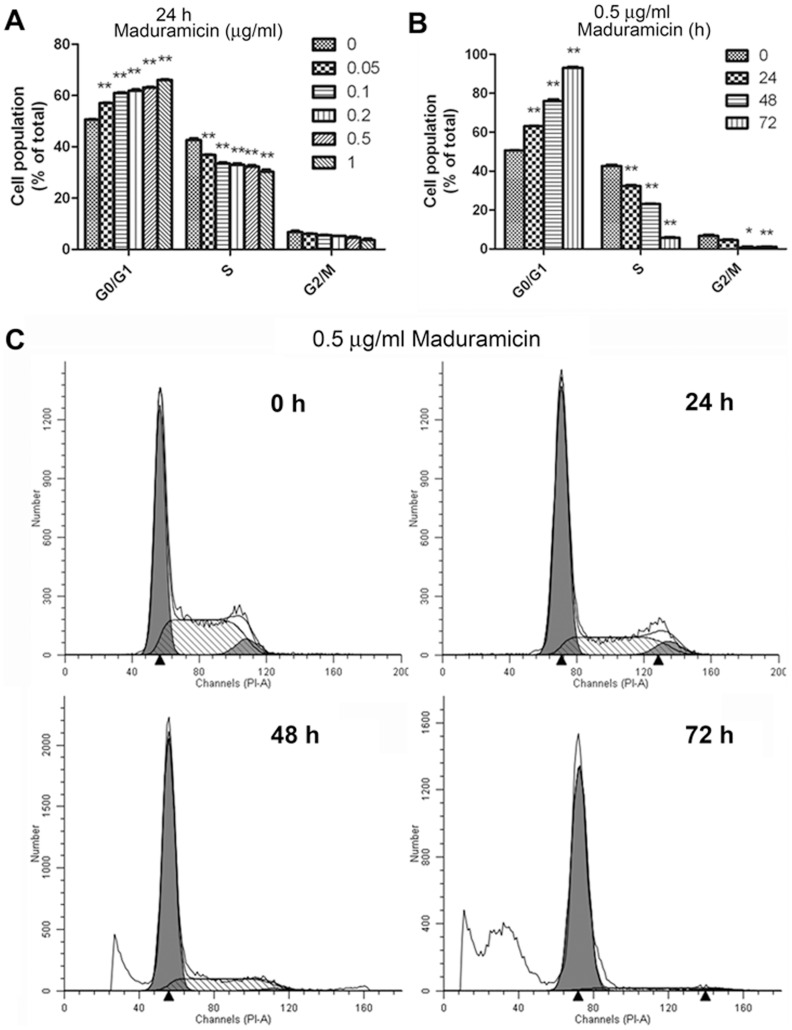
Maduramicin arrests C2C12 cells at G0/G1 phase of the cell cycle.C2C12 cells were treated with maduramicin for 24 h at indicated concentrations (A), or for indicated time at 0.5 µg/ml (B, C), followed by staining with PI and flow cytometry. (A, B) Results are presented as means ± SE (n = 3, corresponding to three independent experiments). *P<0.05, **P<0.01, difference with the control group. (C) Histograms from a representative experiment show the time-course effect of maduramicin on cell cycle profile in C2C12 cells. Note: Maduramicin increased sub-G1 in a time-dependent manner.